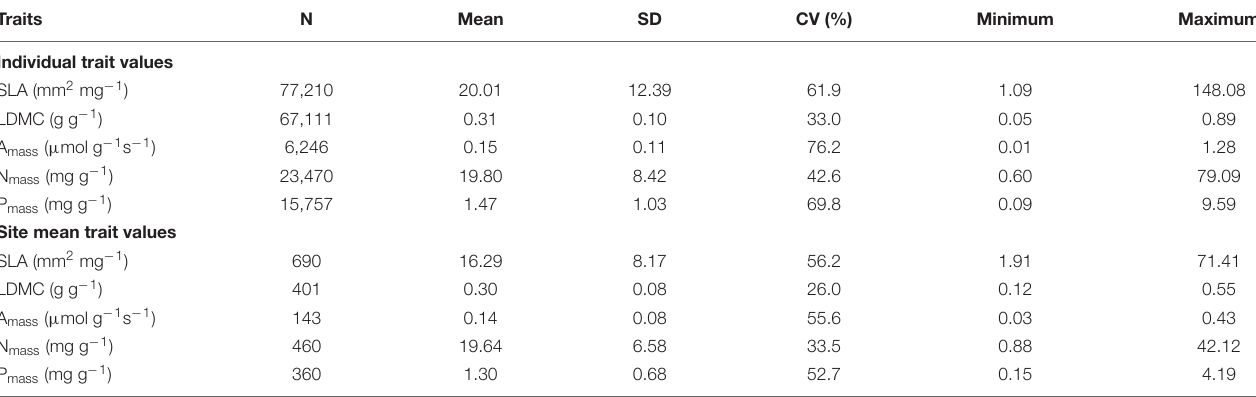
TABLE 2 | Summary of leaf economic traits based on individual species values and site mean values.